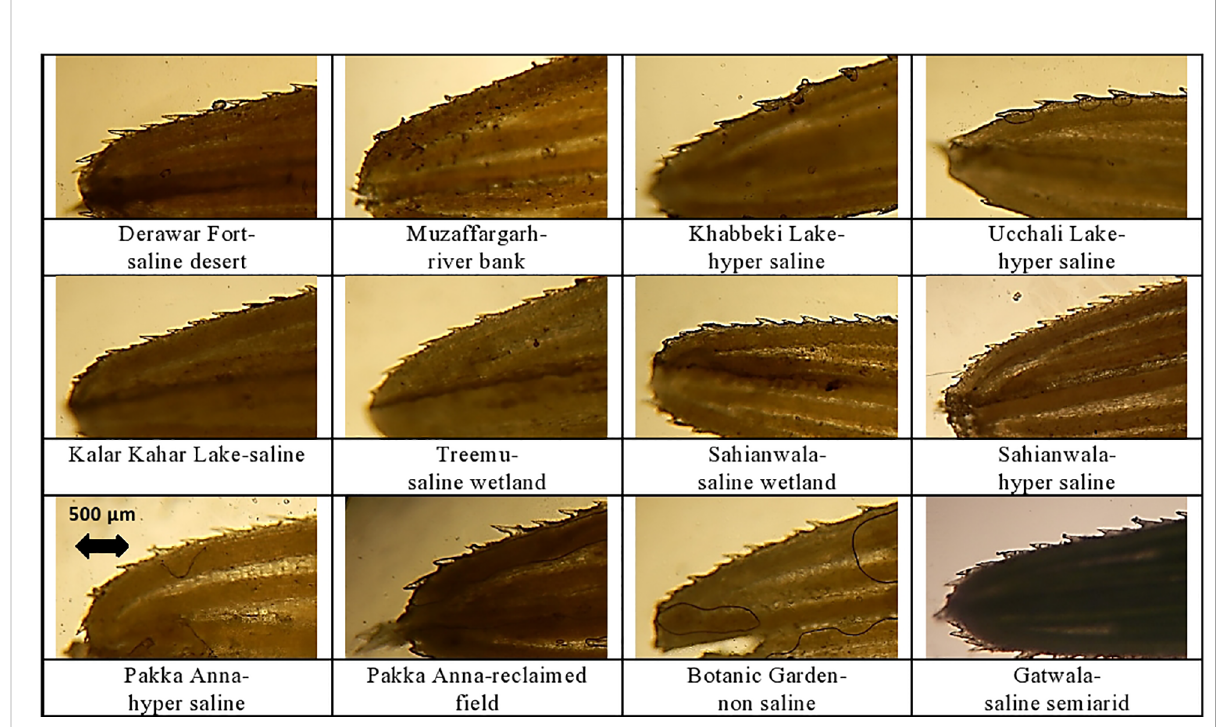
FIGURE 5 Leaf trichomes and leaf blade transverse section of cynodon dactylon ecotypes collected from the Punjab, Pakistan. DF-SD, Derawar fort-saline dessert; M-RB, Muzaffar garh-River bank; KL-HS, Khabbeki Lake-hyper saline; UL-HS, Ucchali Lake-hyper saline; KKL-S, Kalar Kahar Lake-saline; T-SW, Treemu-wetland; S-SW, Sahianwala-saline wetland; S-HS, Sahianwala-hyper saline; PA-HS, Pakka Anna-hyper saline; PA-RF, Pakka Anna- reclaimed fi eld; BG-NS, Botanic Garden-non saline; G-SSA, Gatwala-saline